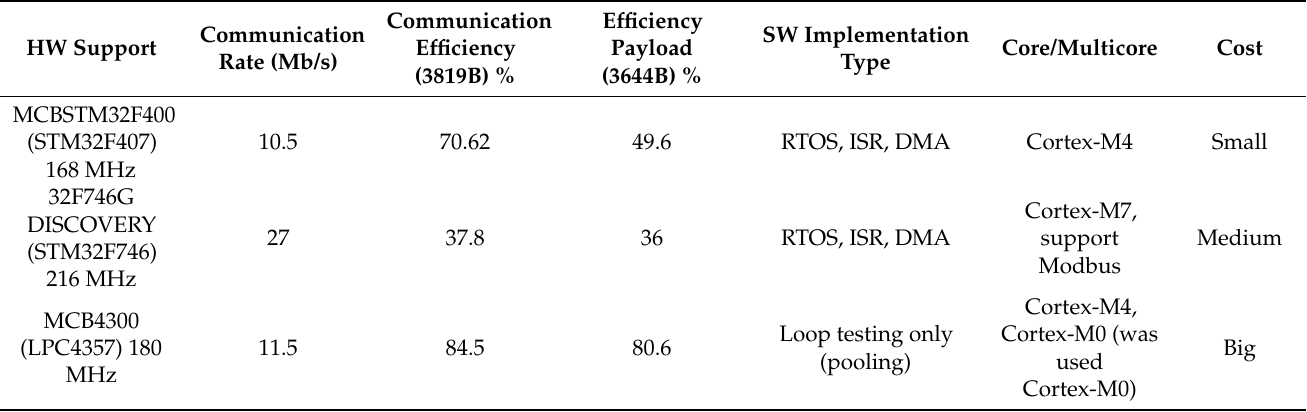
Table 3. Summary of